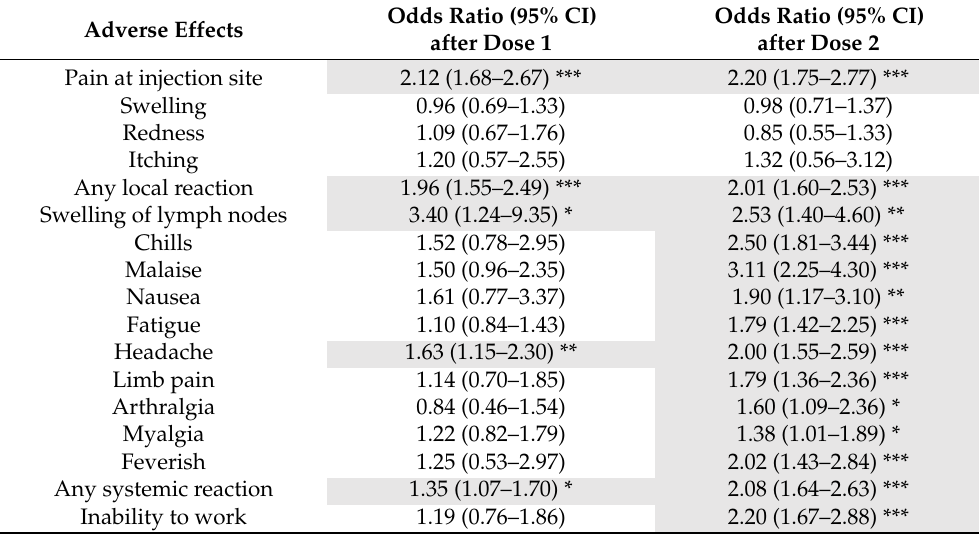
Table 1. Odds ratios of adverse effects after first and second dose of BNT162b2 mRNA vaccine comparing participants aged ≤ 55 years to participants aged ≥ 56 years.